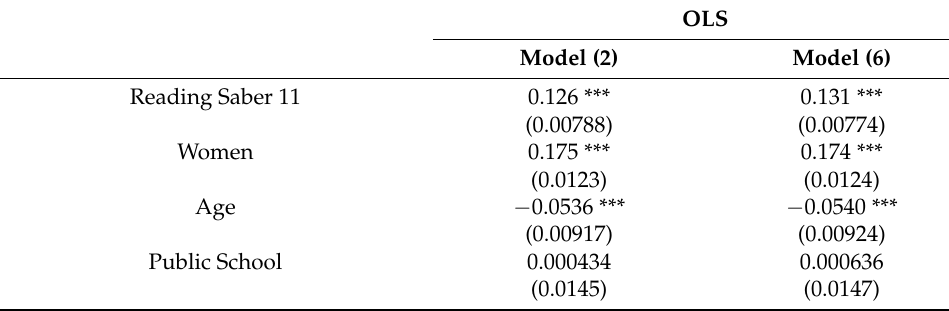
Table A6. Peer effects on academic performance in Communication Skills